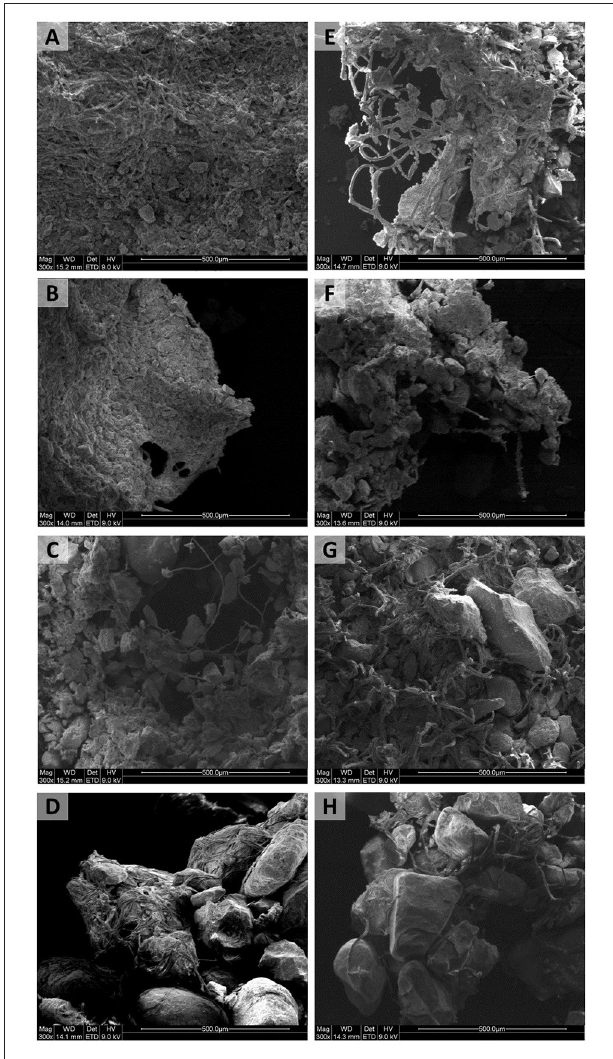
FIGURE 2 | SEM pictures of the soil surface 90 days after inoculation in the different soils. Pictures on the left correspond to P. ambiguum -inoculated soils, while pictures on the right correspond to S. javanicum -inoculated soils. From the top to the bottom: silt loam (A,E) , sandy loam (B,F) , loamy sand (C,G) , and sandy (D,H)